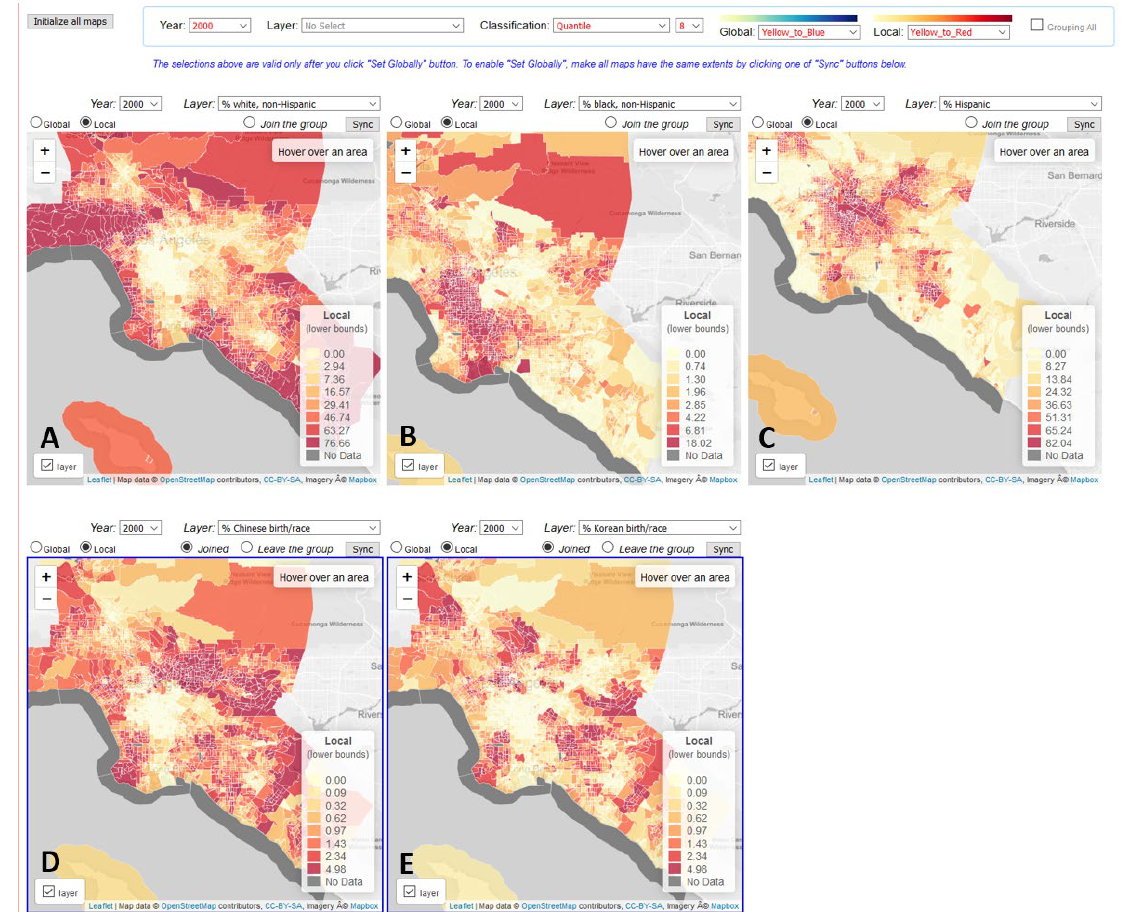
Figure 10. Linking partially selected maps. Maps ( D ) and ( E ) were joined in a group. The maps from left to right represent ( A ) percentage of whites, ( B ) percentage of blacks, ( C ) percentage of Hispanics, (D) percentage of Chinese, and (E) percentage of Koreans.